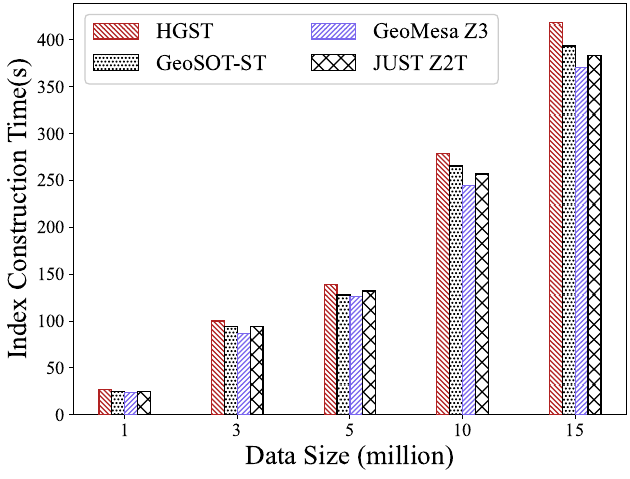
Figure 11. Time of index